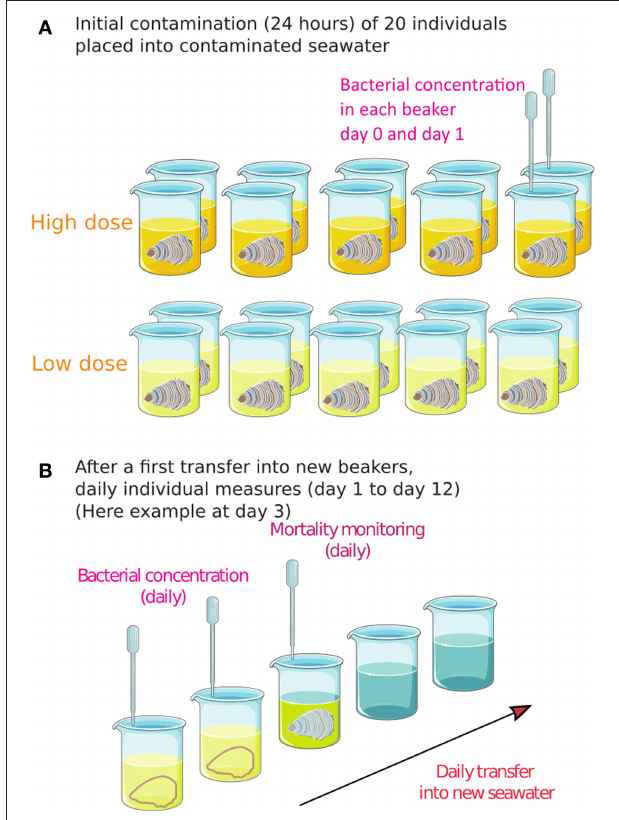
FIGURE 1 | The experimental design for assessing Vibrio aestuarianus transmission from contaminated seawater to contact oysters. (A) Initial exposure of 10 oysters × 2 doses for 24h. (B) After transfer of each individual oyster into a new beaker with clean seawater, daily individual measures were conducted for 12 days. As soon as bacteria were detected in the seawater, the oyster was transferred into a new beaker, and the survival of bacteria was measured daily in the previous beaker (now